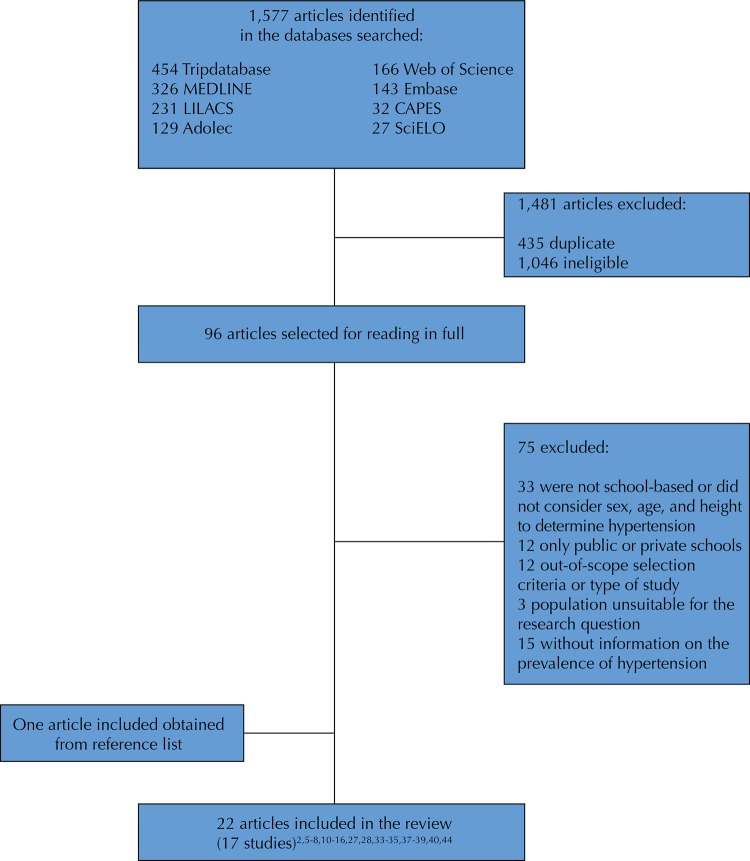
Flowchart of the search result, selection and inclusion of studies.